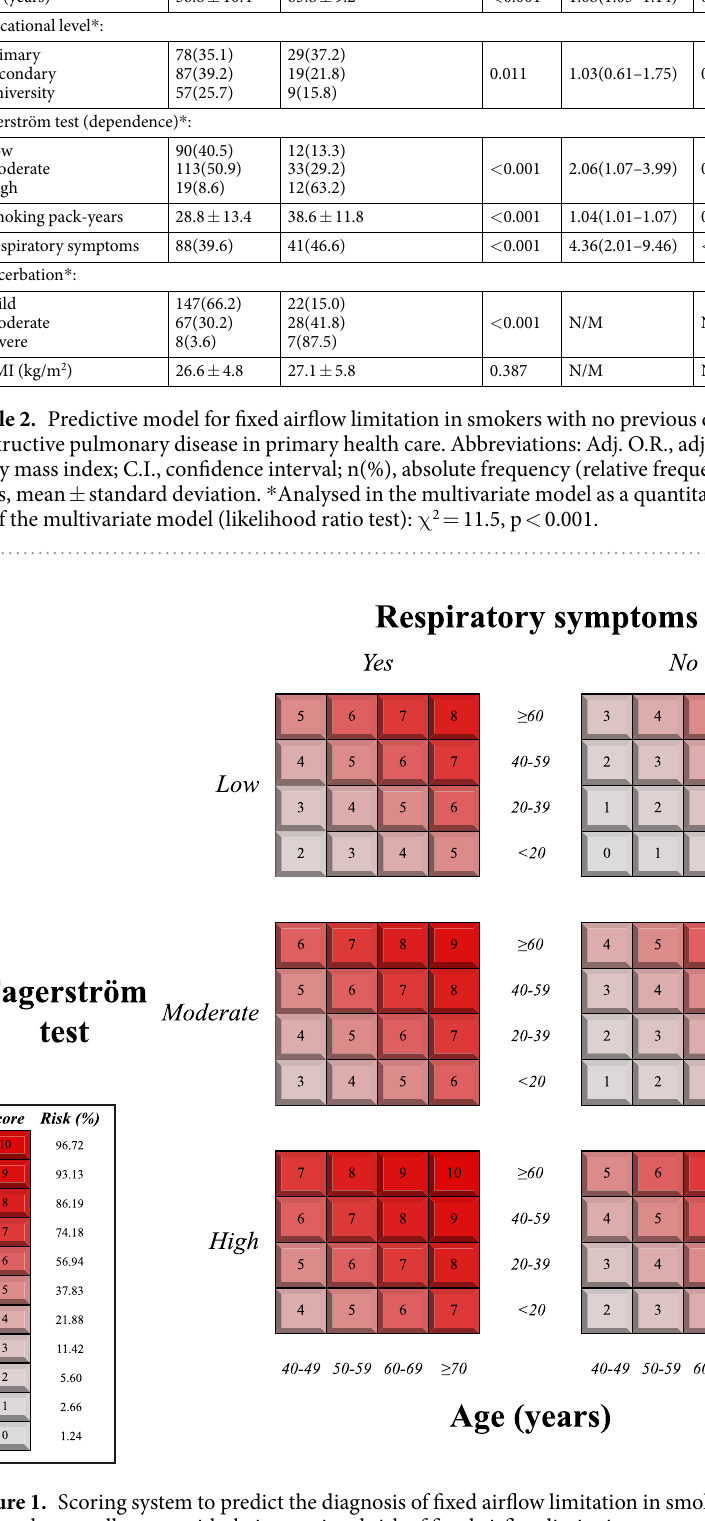
Figure 1. Scoring system to predict the diagnosis of fixed airflow limitation in smokers. The box on the left shows the overall scores with their associated risk of fixed airflow